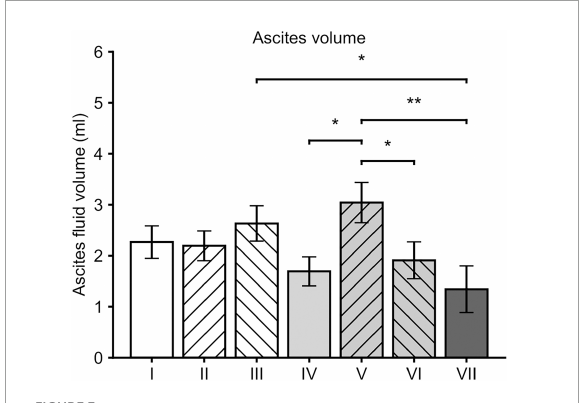
FIGURE3 Mean ascites volumes at the time of sacrification. In general, all the groups that received sVEGFR2 as a part of the gene therapy (groups IV, VI and VII) showed lower volumes of ascites when compared to the group V. When compared to the group III, group VII was the only group with a significantly lower ascites volume. Results were considered statistically significant with values of p < 0.05* and p < 0.01**.